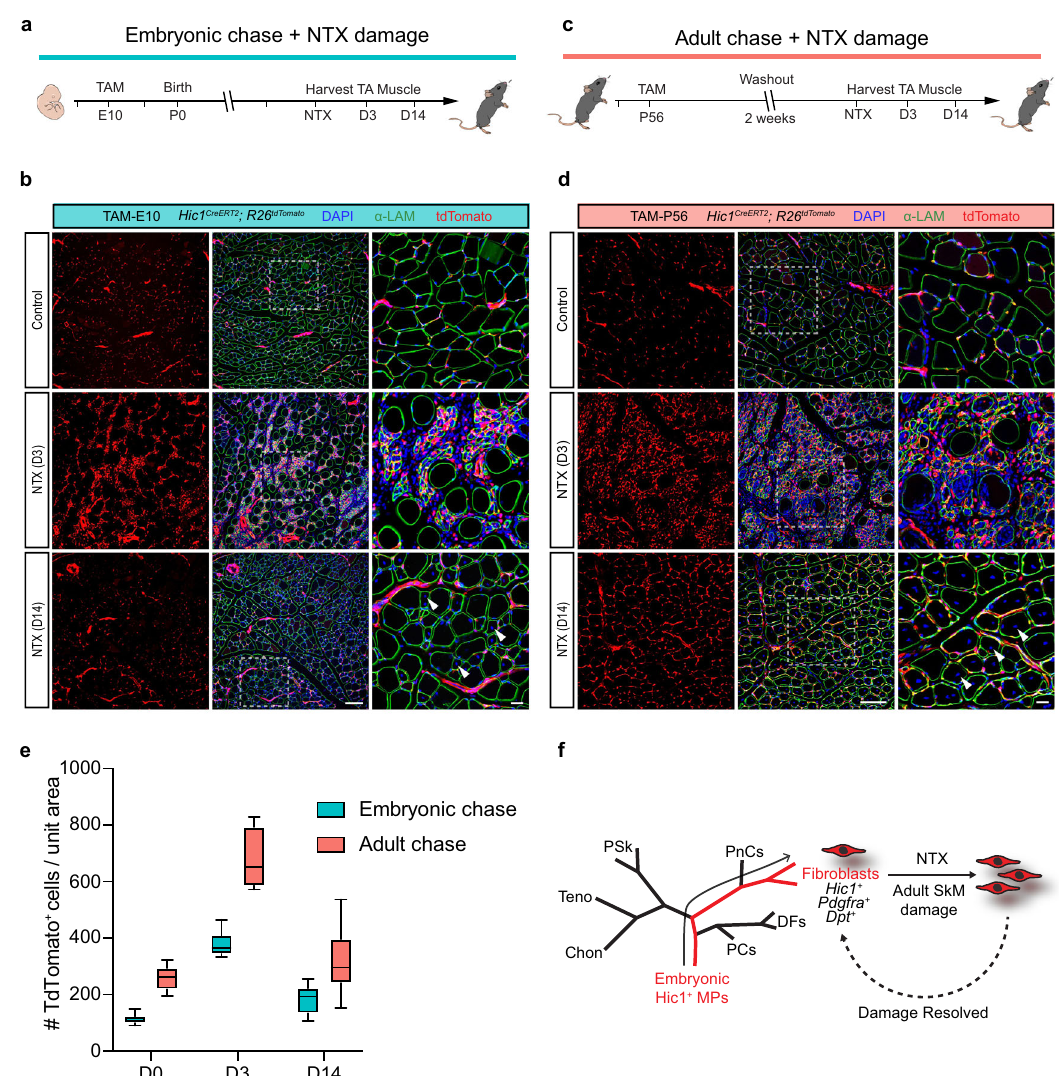
Fig. 9 | Embryonic Hic1 -lineage fi broblasts persist post-natally and support muscleregeneration. a Schematic of experimental design for lineage tracing of embryonic Hic1 + progenitors into adulthood and subsequent muscle injury. b Representative tibialis anterior (TA) muscle sections from embryonic lineage- traced (TAM at E10) Hic1 CreERT2 ; R26 tdTomato mice at 3- and 14-days post NTX- induced injury. Contralateral TA shown as control. n =2 biologically indepen- dent animals per damage timepoint. Scale bars, 100 µ m, 20 µ m inset. Arrow- heads indicate centrally located nuclei. c Schematic of experimental design for lineage tracing of adult Hic1 + progenitors and subsequent muscle injury. d Representative tibialisanterior (TA)musclesectionsfromadultlineage-traced (TAM at P56) Hic1 CreERT2 ; R26 tdTomato mice at 3- and 14-days post NTX-induced